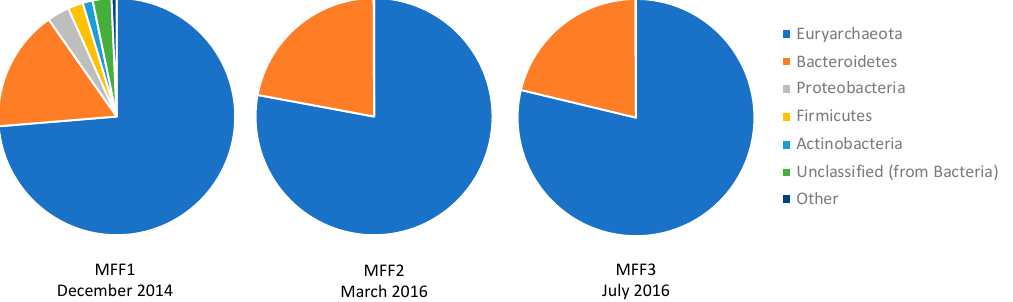
Figure 2. Taxonomic hits by phylum. Each slice indicates the number of reads with predicted 16SrRNA genes annotated to the indicated phylum. Samples were named MFF1 for the first sampling, MFF2 for the second sampling and MFF3 for the third sampling (MFF stands for “Muestra Final Fraternidad” which means Fraternidad Final Sample). Phylum Euryarchaeota were shown to be dominant in the three samples (73.69% for MFF1, 77.92% for MFF2, and 78.75% for MFF3), followed by Bacteroidetes (16.59, 22.03, 21.18%, respectively), and Proteobacteria (3.03, 0.05, 0.07%, respectively). Other groups include Acidobacteria , Chlamydiae , Cyanobacteria , Deinococcus-Thermus , Fusobacteria , Planctomycetes , and Verrucomicrobia , with less than 1% in MFF1.